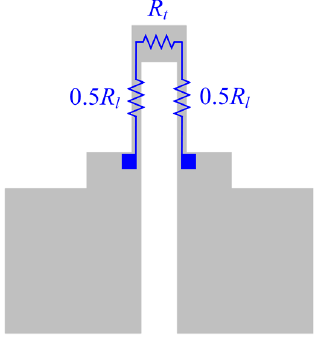
Figure 4. A schematic diagram of the resistance of the strain gauge.